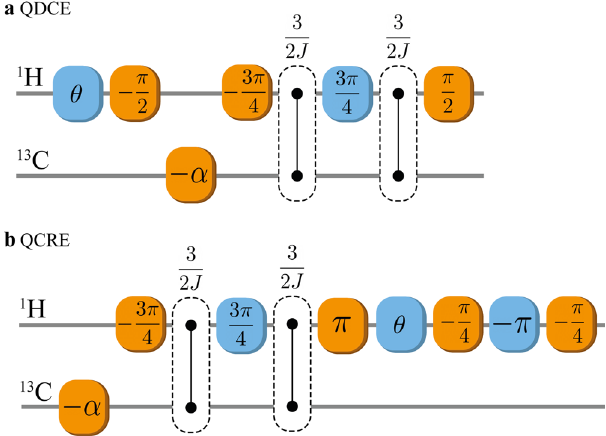
Fig. 5 Pulse sequences for the two interferometric scenarios. a Sequence for the original version of quantum delayed-choice experiment (QDCE) described in Fig. 1a. For the sake of optimization, the fi rst superposition operation and the phase shifter were implemented by two rotations (rotations θ and (cid:3) π ). The quantum-controlled interference was performed 2 using local operations on the system ( 1 H) and on the controller ( 13 C), as well as two free evolution under the scalar coupling. b Pulse sequence for the quantum-controlled reality experiment (QCRE) described in Fig. 1b, where the quantum-controlled interference appears as the fi rst operation followed by the phase shifter and the interference operation. The most relevant contributions to the total time duration of each experiment are the free evolution, so both pulse sequences last approximately the same time ( ≈ 14